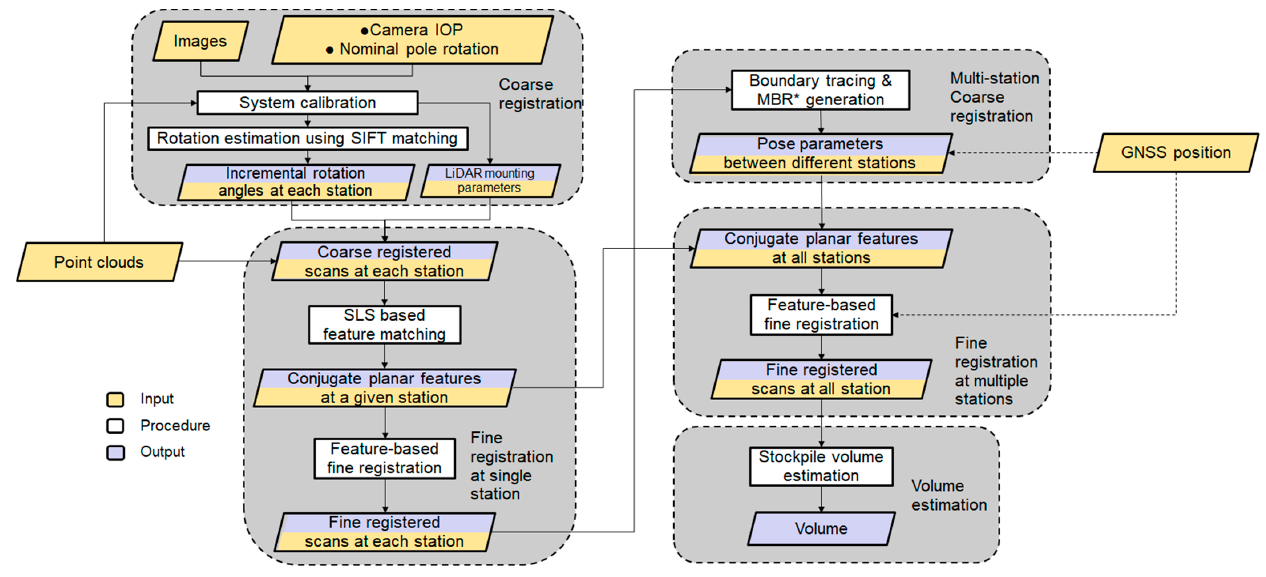
Figure 6. Workflow of the proposed stockpile volume estimation using the SMART system. * MBR: minimum bounding rectangle.